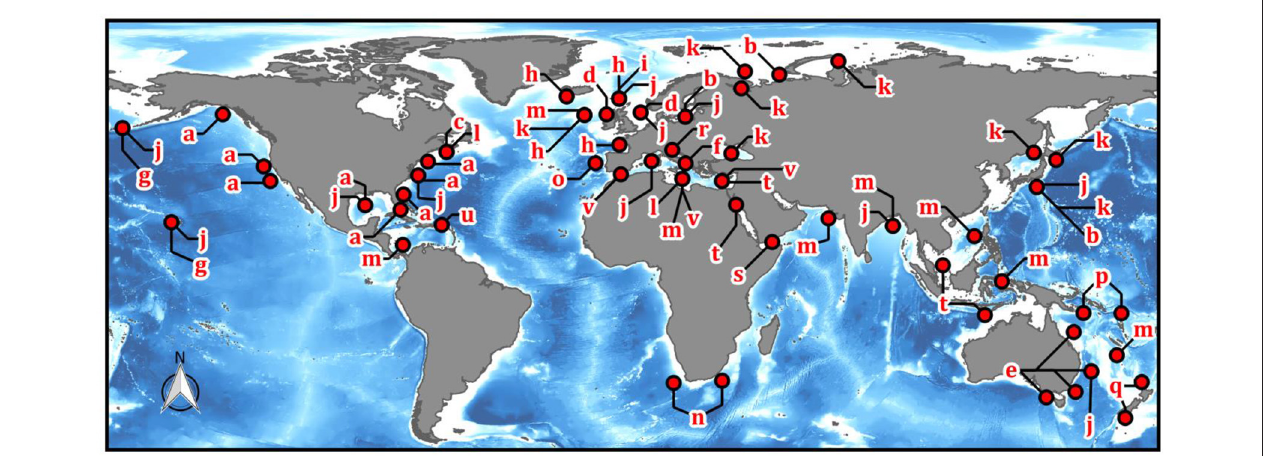
FIGURE 3 | Global distribution of documented marine sites with munitions present (includes conventional weapons, chemical weapons, and UXO). Letters refer to literature references: a, MEDEA (1997) and Bohaty (2009); b, MEDEA (1997); c, Ampleman et al. (2004); d, Missiaen and Henriet (2002); e, Plunkett (2003); f, Amato et al. (2006a,b) ; g, Bearden (2007); h, Nixon (2009); I, HELCOM (1995); j, Brankowitz (1989); k, James Martin Center for Nonproliferation Studies (2017); l, Bull (2005a,b); m, US ARMY (2001); n, Godschalk and Ferreira (1998); o, Thiel (2003); p, Francis and Alama (2011); q, Royal New Zealand Navy (2015); r, Obhodas et al. (2010) and Valkovic et al. (2009); s, Nadim et al. (2008) and National Geospatial-Intelligence Agency (2017); t, Landmine Action (2005); u, Porter et al. (2011); v, UNEP/MAP (2009). Note that the map resolution is coarser than the number of actual munitions dumps; for example, the OSPAR report by Nixon (2009) (letter h) contains 148 individual munitions dumpsites. (Image drawn using QGIS, with data from: The GEBCO_2014 Grid, version 20150318, Wessel and Smith,